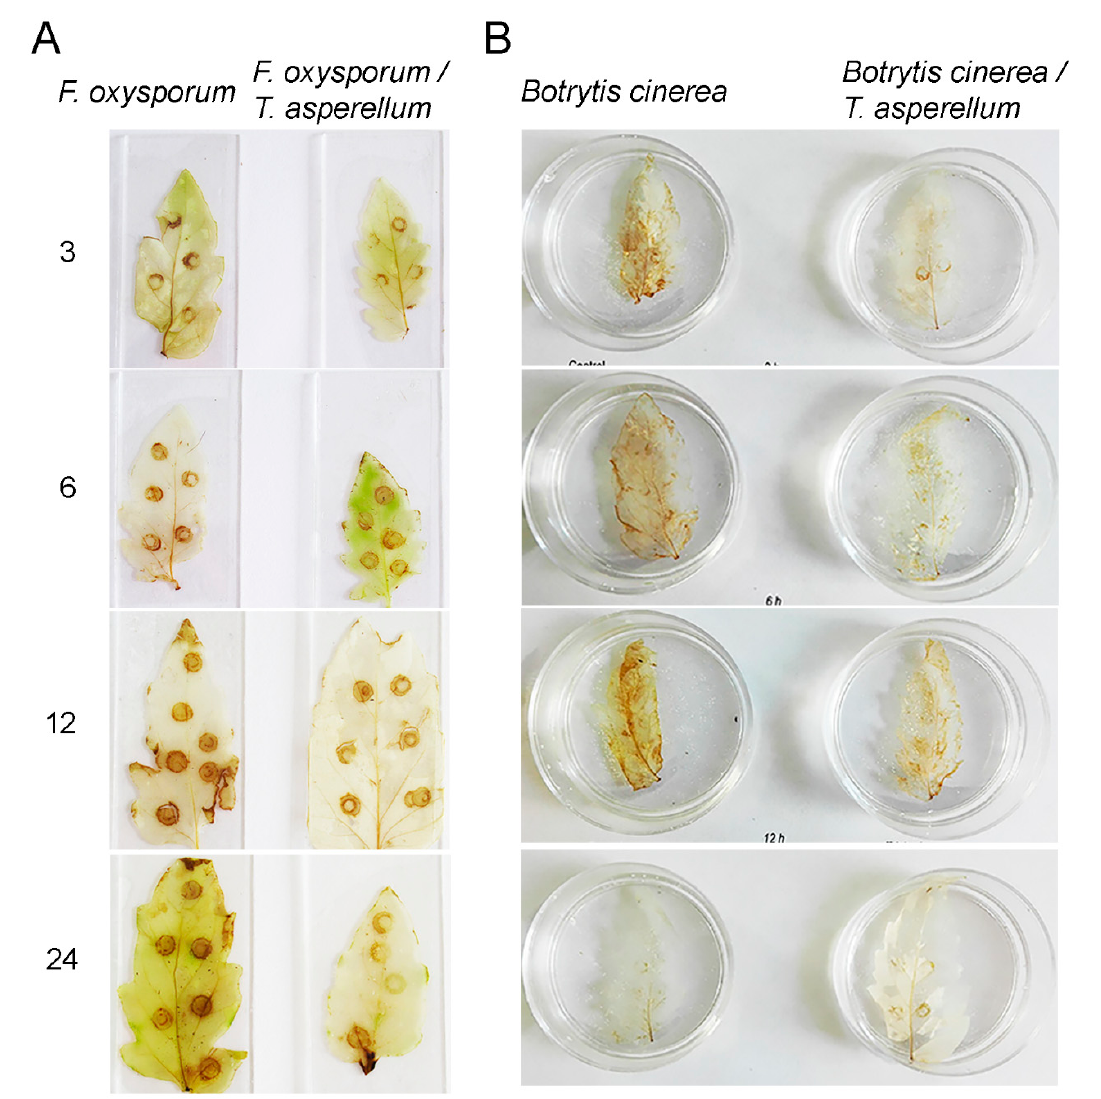
Figure 4. T. asperellum prevents ROS accumulation in response to Fusarium and Botrytis infection on tomato plants. Non- and pretreated tomato plants with T. asperellum were inoculated with F. oxysporum ( A ) or B. cinerea ( B ), and leaves were stained at different time periods (3, 6, 12 and 24 h) with DAB. Infection with Fusarium was in full plants while infection of Botrytis was in detached leaves. The experiments were repeated twice.